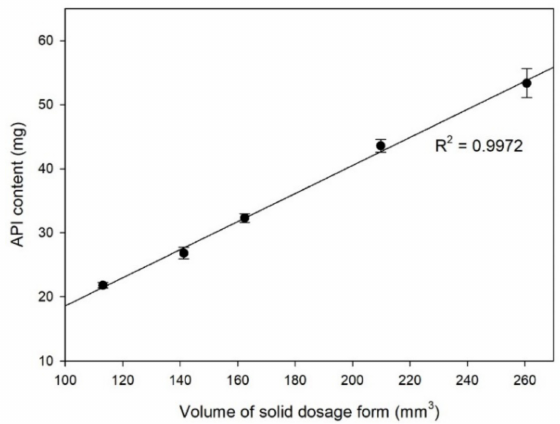
Figure 6. Correlation between the volume and API content of solid dosage